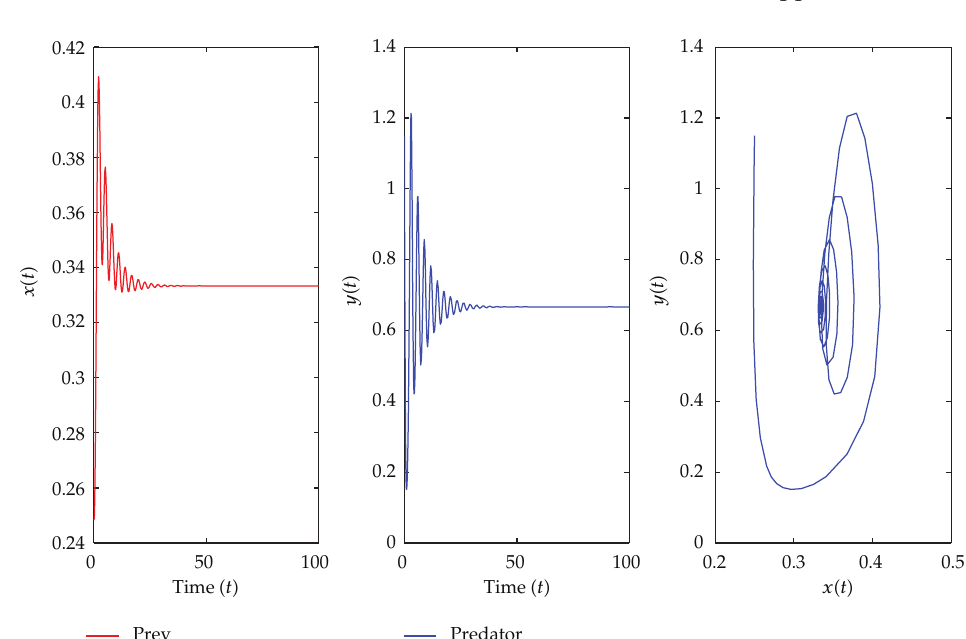
Figure 5: E (cid:7) 0 . 3333 , 0 . 6666 (cid:8) is asymptotically stable when τ (cid:6) 0 . 64 < τ 0 (cid:6) 0 . 7015 with initial value 0.25, 1.15.